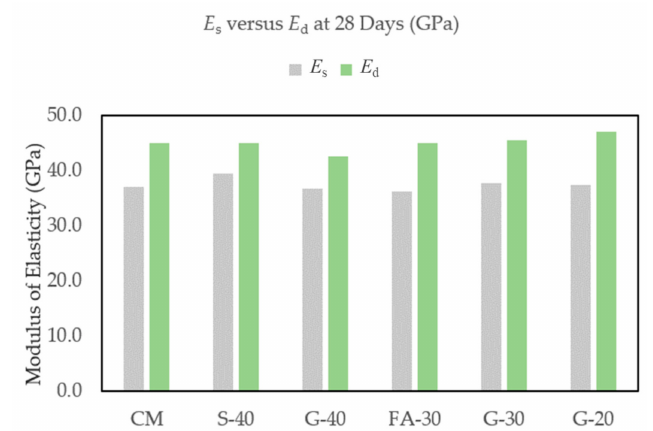
Figure 9. Comparison of E s and E d at 28